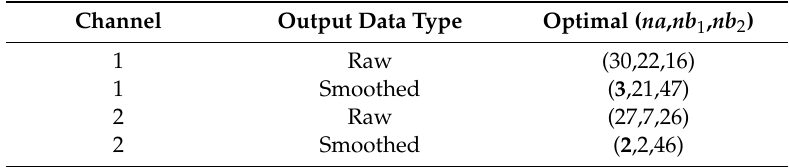
Table 3. Optimal indices for ARX models on both channels in case of two-step optimization